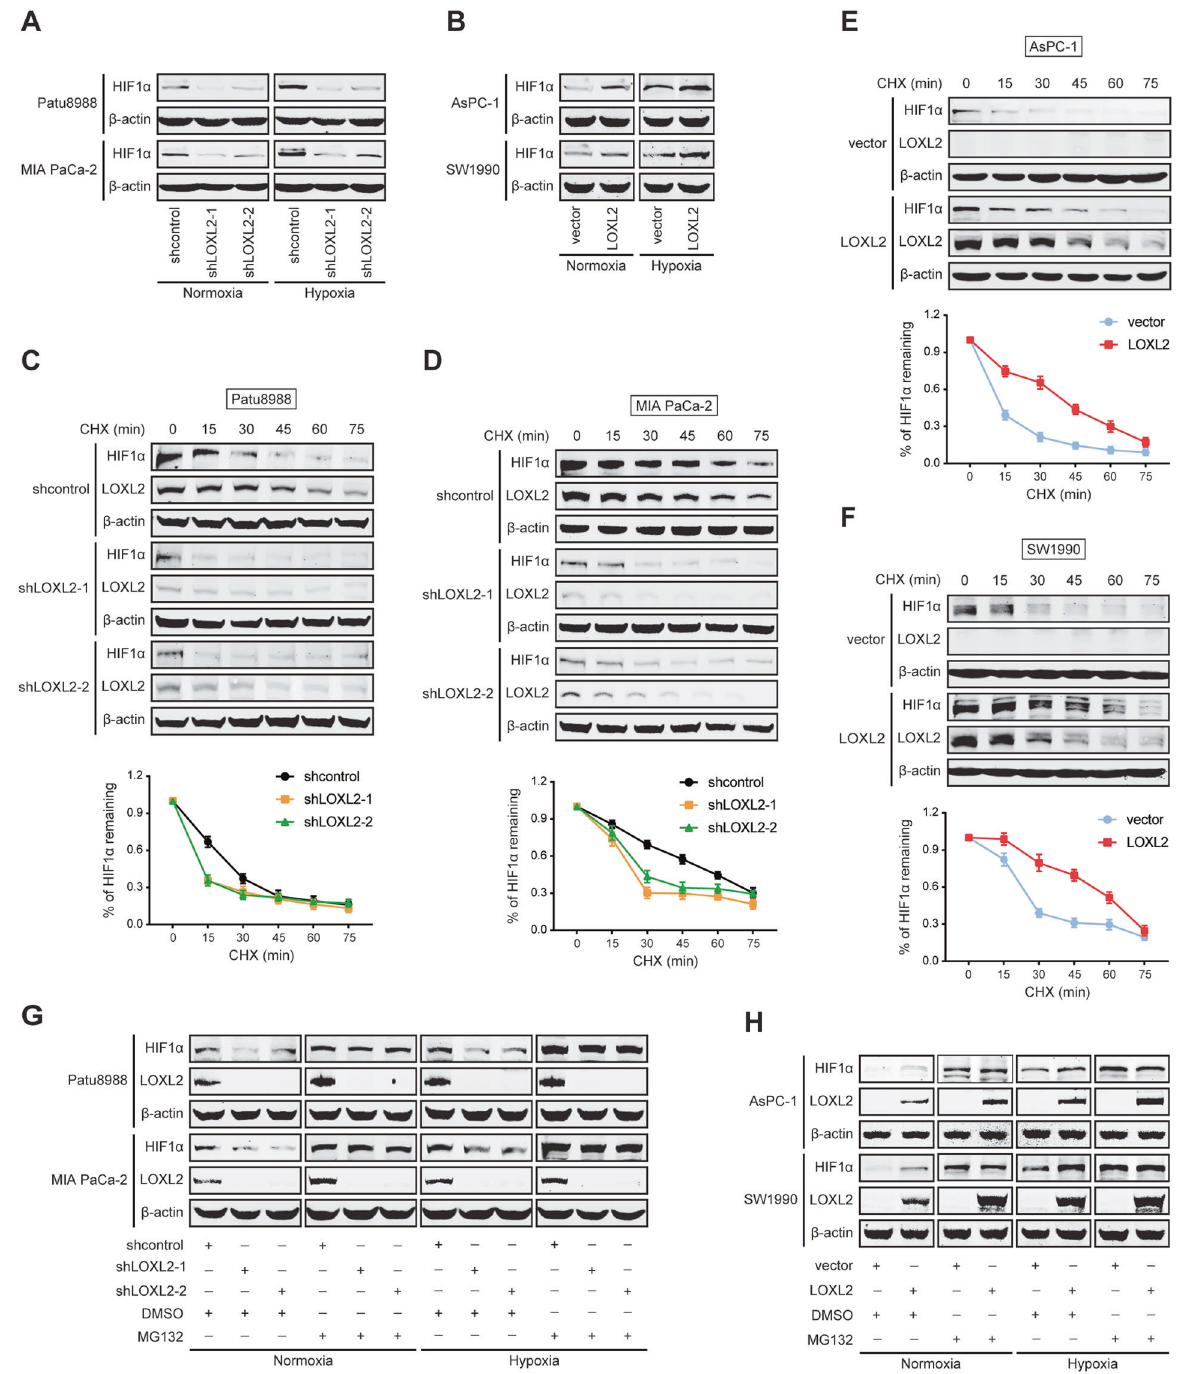
Fig. 6 LOXL2 stabilizes HIF1 α protein. A Western blotting showing HIF1 α expression in LOXL2 knockdown and control cells under normoxic and hypoxic conditions. B Western blotting showing HIF1 α expression in LOXL2-overexpressing and vector control cells under normoxic and hypoxic conditions. C , D HIF1 α stability was examined by western blotting in LOXL2 knockdown and control cells. The cells were exposed to hypoxia for 6 h followed by incubation with 20 μ g/ml cycloheximide (CHX) for the indicated times. E , F HIF1 α stability was examined by western blotting in LOXL2-overexprssing and vector control cells. The cells were exposed to hypoxia for 6 h followed by incubation with 20 μ g/ml CHX for the indicated times. G Western blotting showing HIF1 α expression in LOXL2 knockdown and control cells treated with or without 10 μ M MG132 for 6 h under normoxic and hypoxic conditions. H Western blotting showing HIF1 α expression in LOXL2-overexpressing and vector control cells treated with or without 10 μ M MG132 for 6 h under normoxic and hypoxic